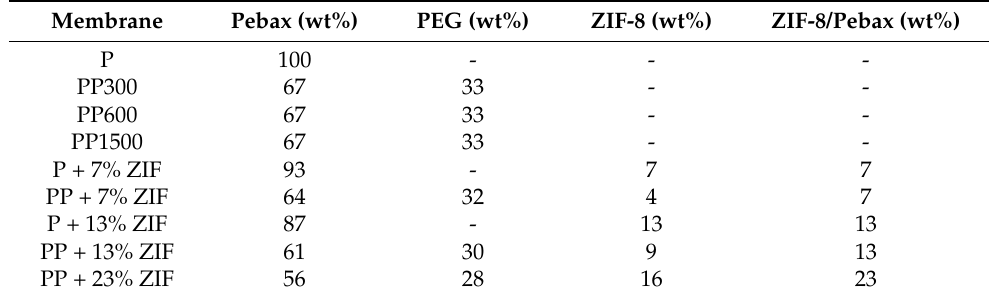
Table 1. Composition of prepared neat Pebax and Pebax-based hybrid